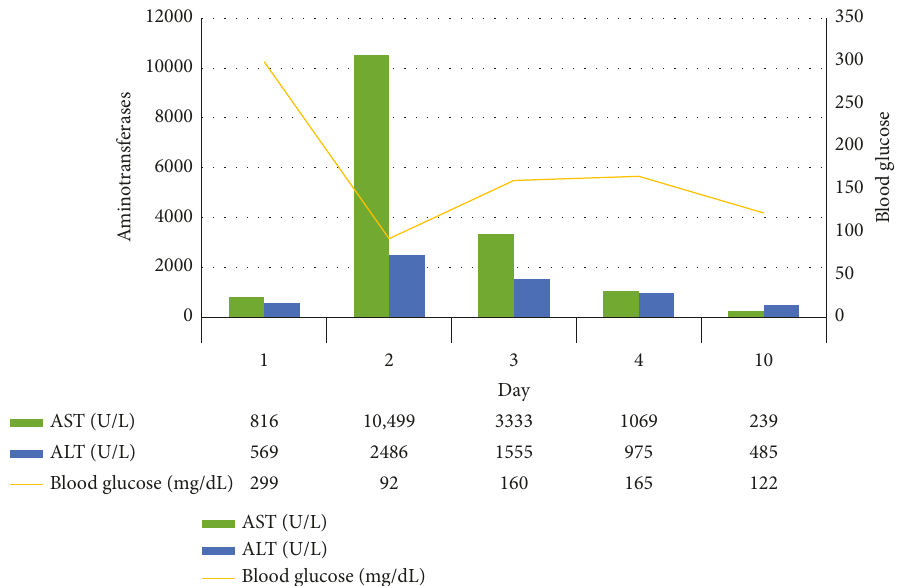
Figure 3: Relationship between the trends of aminotransferases and blood glucose levels. AST: aspartate aminotransferase; ALT: alanine